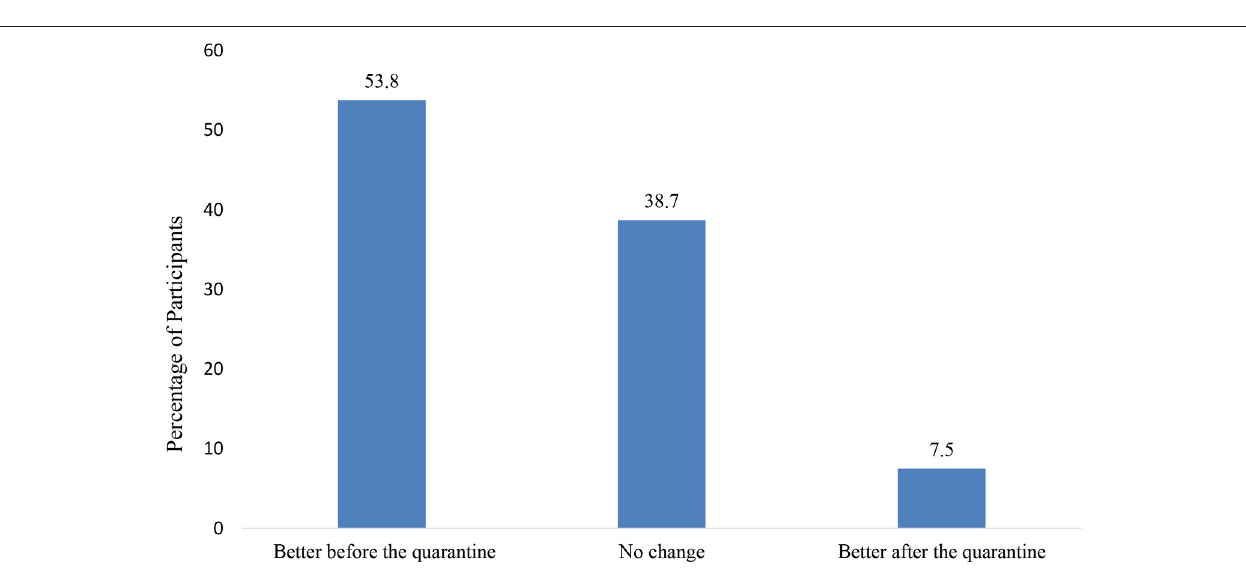
FIGURE 5 | Caregiver or parent rating the mental health wellbeing of the child when comparing it between before and during